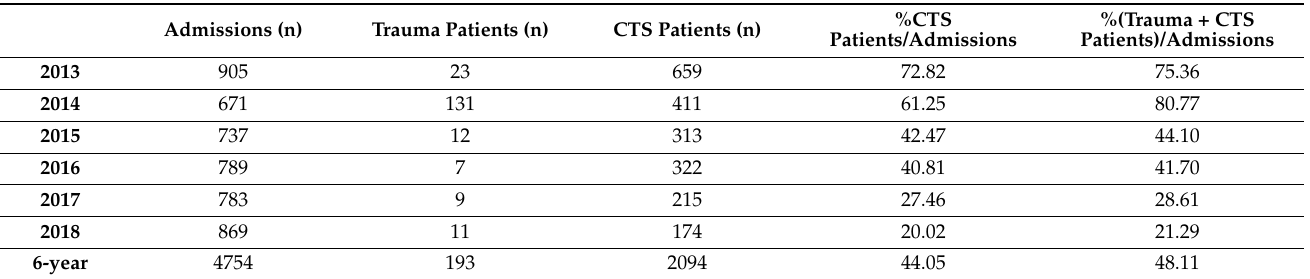
Table 1. Annual number of admissions, trauma patients, cardiovascular surgery patients, and relevant percentages in ICU, January 2013 to December 2018.